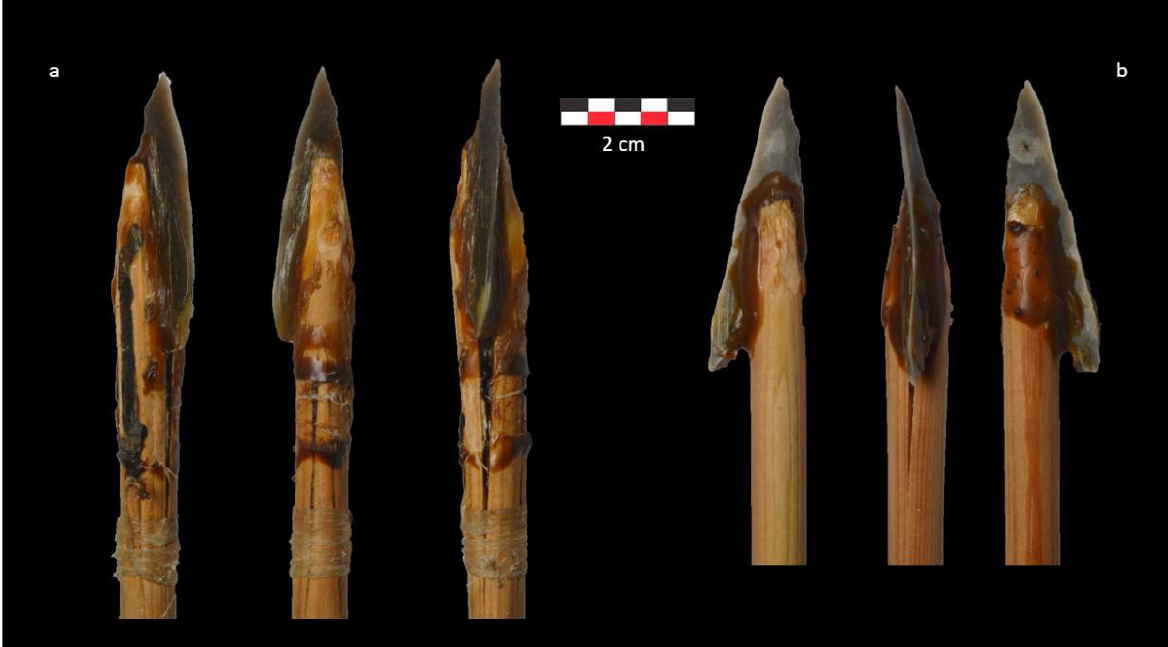
Figure 17. Experimentally reproduced and hafted curved backed points: a) Exp112_07 and b)